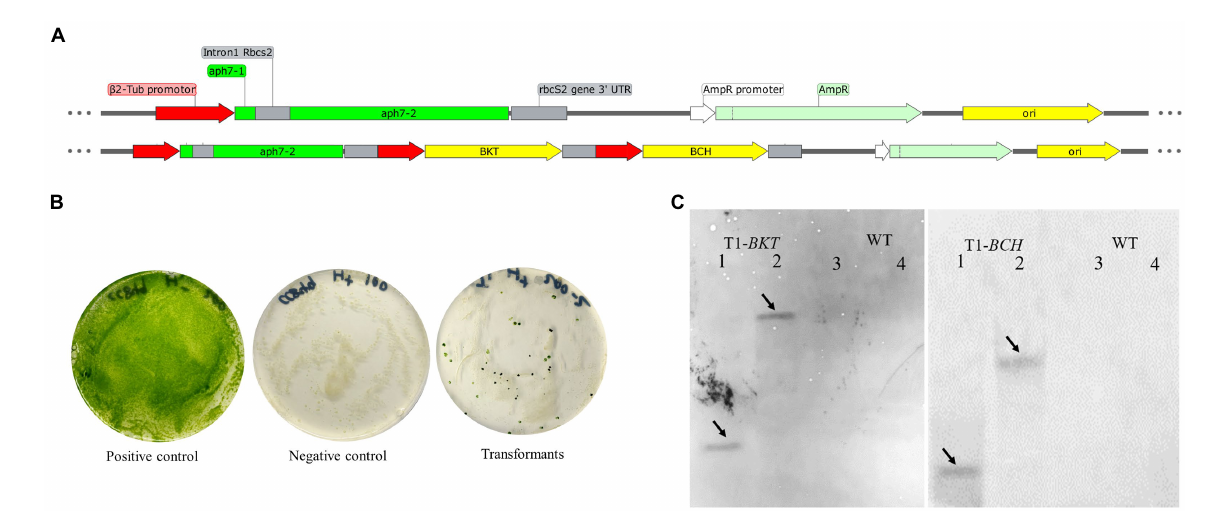
FIGURE 1 Diagrammatic sketch map of foreign gene expression vector and transformation results of foreign genes. (A) The foreign gene expression vector was constructed based on plasmid pHyg3. The names of each sequence are marked in the figure. (B) Growth results of transgenic algae strains. The positive control treatment was that the wild type was cultured on the medium without hygromycin B, the algal colony grew normally, and the culture plate was green. The negative control treatment was that the wild type was cultured on the culture medium containing hygromycin B, and the algal colony was completely albino and died 2 weeks later. The transformed algal strain was endowed with hygromycin B resistance and formed single algal colonies on the plate. (C) Southern blotting results of BKT and BCH in T1. The solid line arrows indicate the position of the band. Lane 1, 2 are T1 and 3, 4 are WT. For the detection of BKT , 1 and 3 were digested with Sac I/ Hin dIII. Two and Four were digested with Bam HI/ Sal I. For the detection of BCH , 1 and 3 were digested with Bgl II/ Mlu I. Two and Four were digested with Nde I/ Xho I.